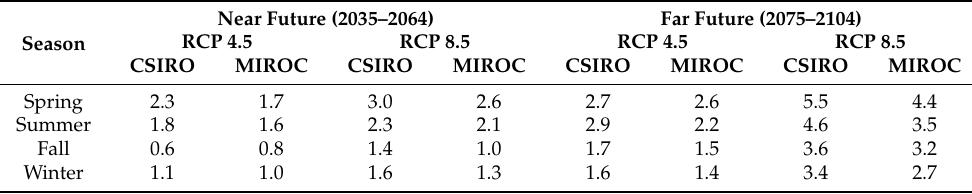
Table 5. Projected seasonal temperature increases.